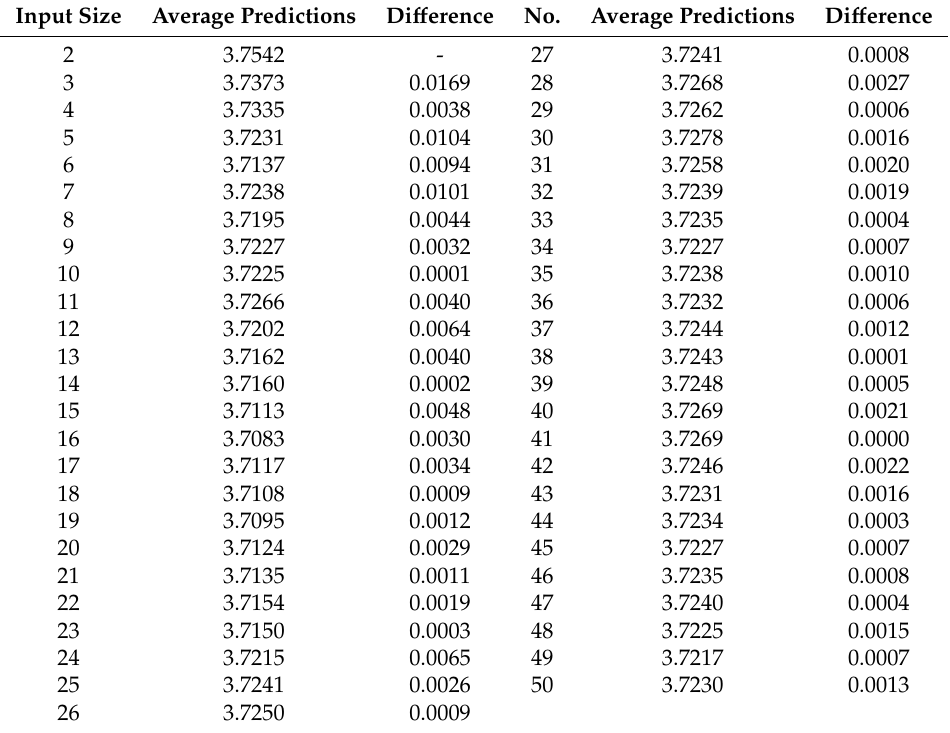
Table 6. Changing average of prediction and di ff erence for each range (the user-based filtering: the cosine